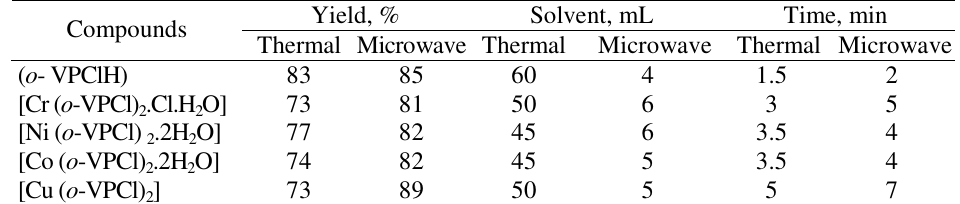
Table 1. Comparison between conventional and microwave methods of synthesis Yield, % Solvent, mL Time, min